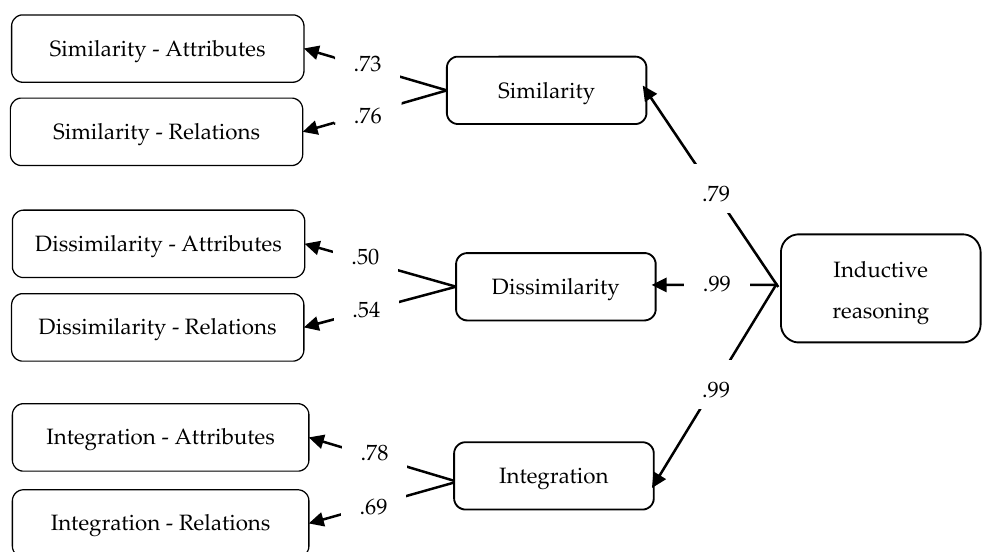
Figure 1. Hiearchical model with data parameters (factor loadings) suggested by Christou and Papageorgiou (2007, p. 63).